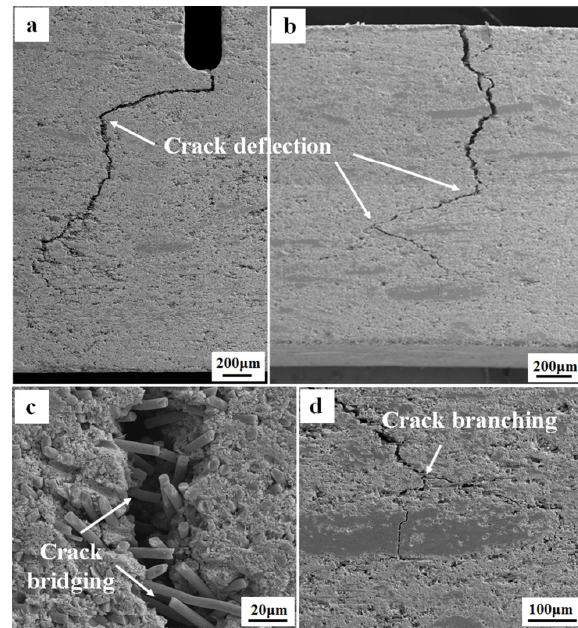
Fig. 6 Crack propagation on the polished surfaces of ZSC30 revealing (a, b) crack deflection, (c) crack bridging, and (d) crack branching mechanisms.